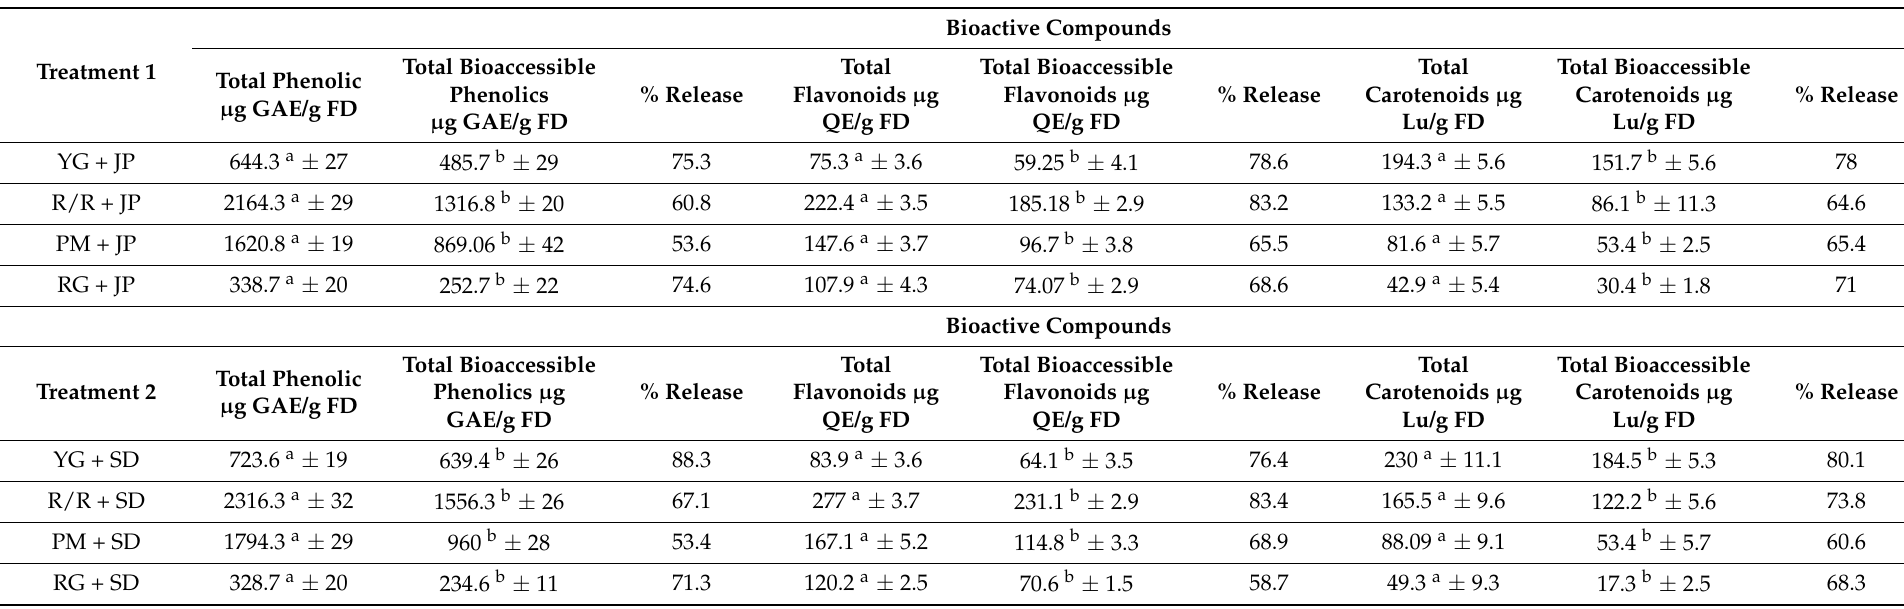
Table 1. Concentration of total bioactive compounds in potatoes cultivars mixed with two roasted peppers, bioaccessibility, and percentage release during in vitro digestion experiment. Data are the mean of three replicates with standard deviation and are expressed as per gram of freeze-dried weight. Significant differences between bioactive compounds before ( a ) and after digestion ( b ) are denoted by different letters, while the same or shared letters indicate that they are not